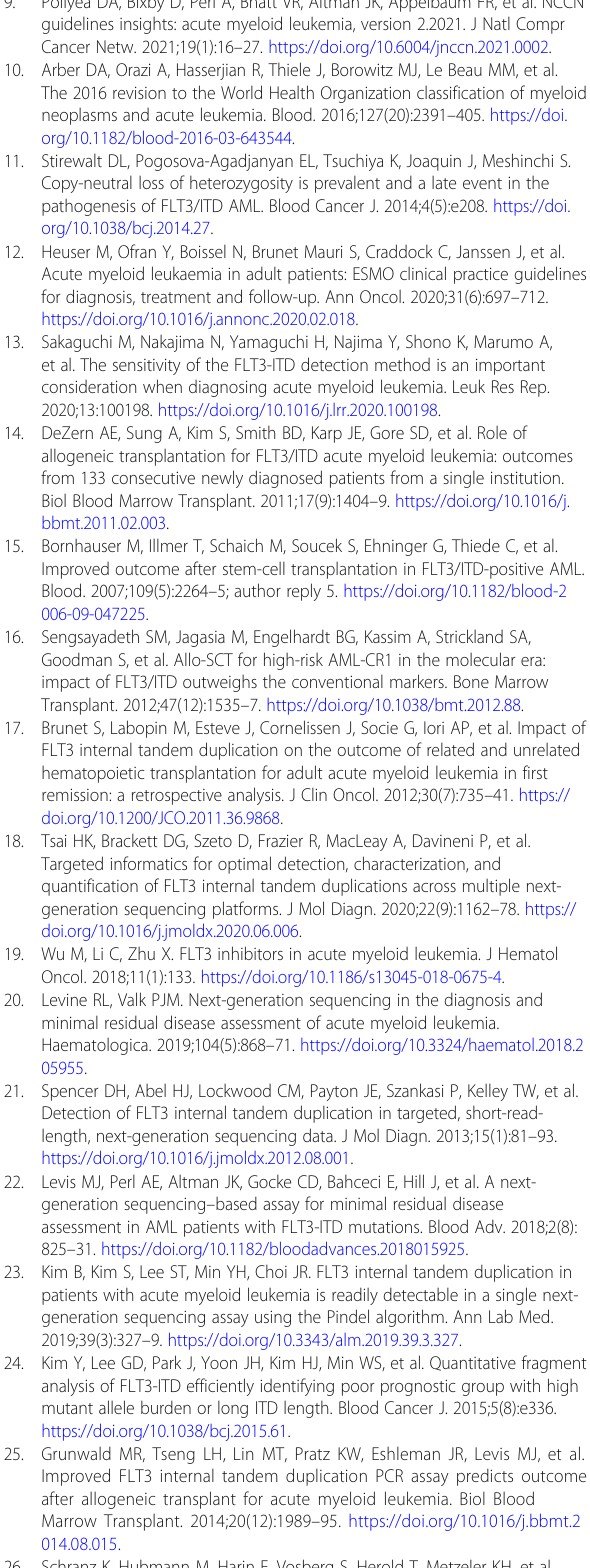
Table 2 . Clinical information and FLT3 ITD results of samples obtained from patients. Supplementary Table 3 . Clinical and biological characteristics of the studied patients with follow up samples. Supplementary Fig. 1 . The bioinformatics pipelines used in this study. Supplementary Fig. 2 . FLT3 ITD detection result by fragment analysis and by NGS in acute myeloid leukemia patient with discrepant case (Patient